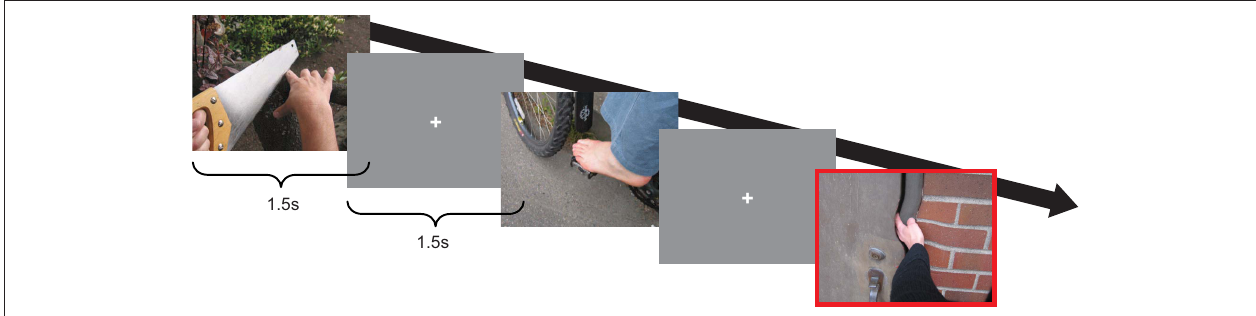
FiGurE 1 | The experimental paradigm. Subjects were presented with pictures depicting limbs painful and non-painful situation, interleaved with gray fixation screens. 10% of the pictures showed a small rotation in the center of the picture (red highlight), the total number of which they had to internally count and report back after